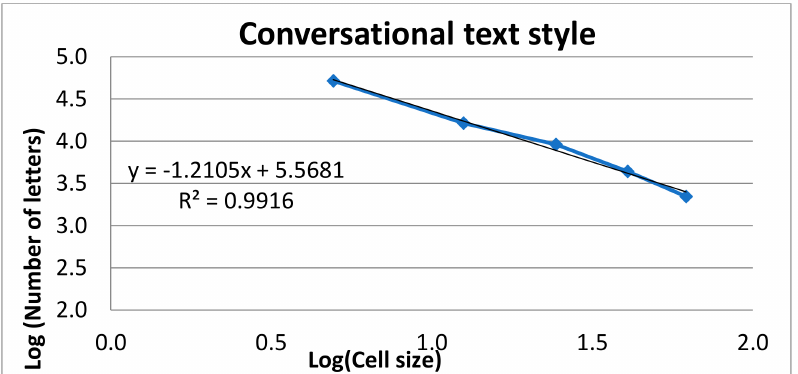
Figure 4. Approximation of fractal values. The value of the fractal dimension D is determined by the absolute value of the angular coefficient for the equation of the trend line of the graph, i.e., the fractal dimension of this sequence of discrete quantities in the case of the text is equal to D =